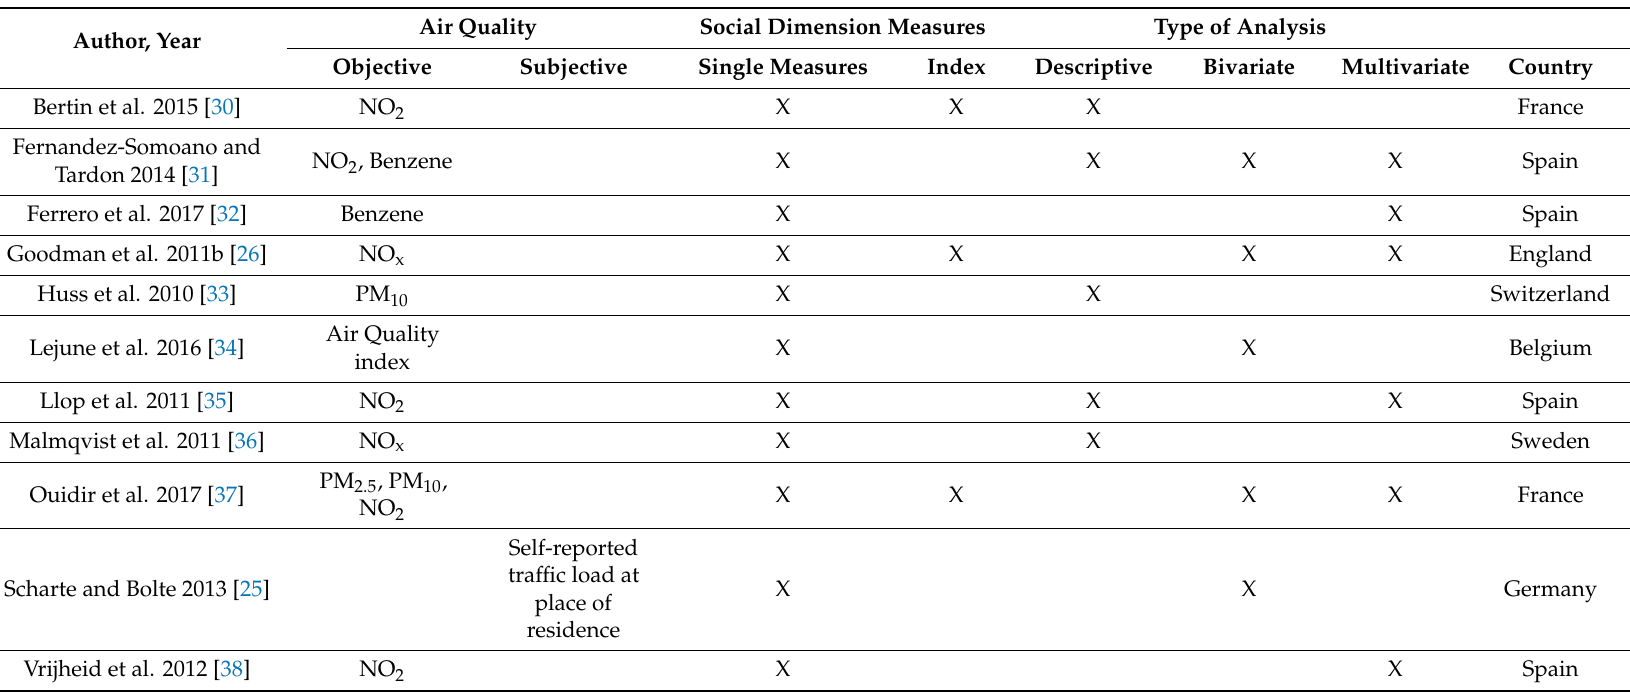
Table 1. Description of 11 studies using individual data. (particulate matter under 2.5 and 10 microns in diameter, PM 2.5 and PM 10 ,